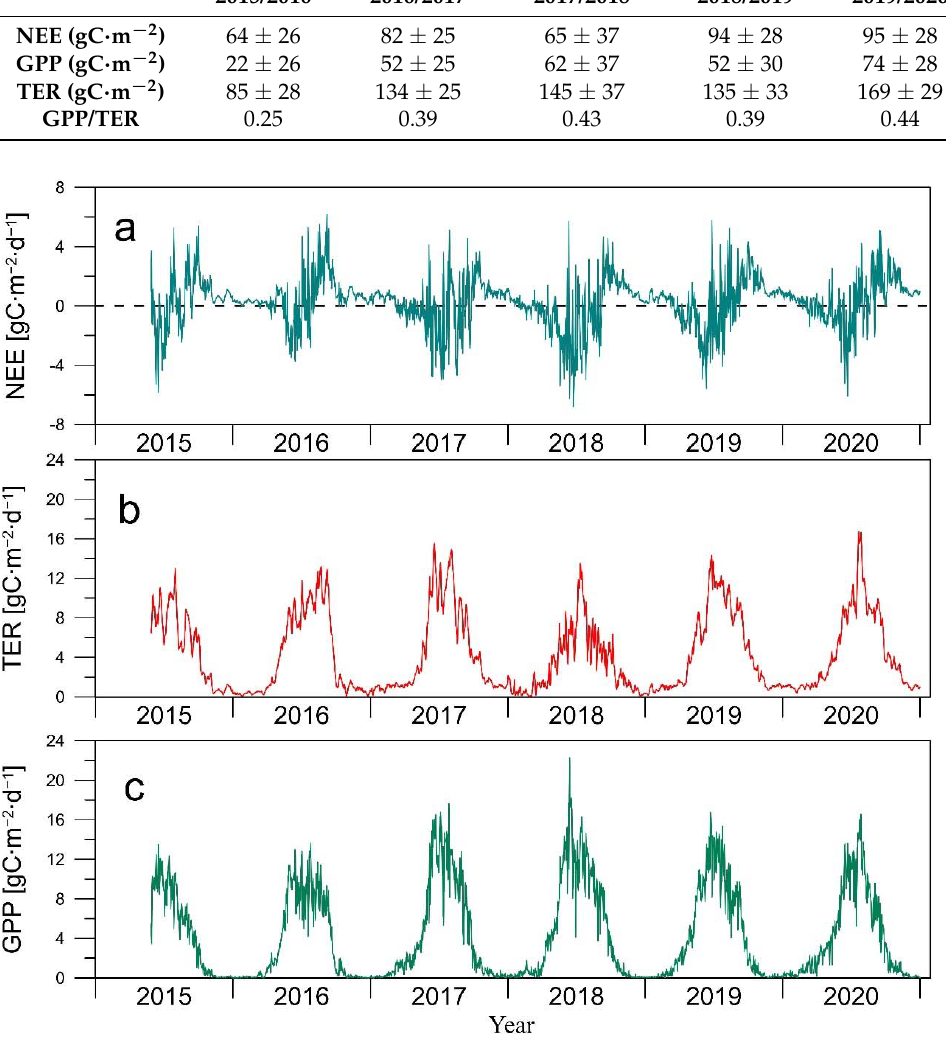
Figure 3. Seasonal courses of the daily sums of CO 2 fluxes in the nemorose spruce forest in the 2015–2020 period: ( a ) net ecosystem exchange (NEE), ( b ) total ecosystem respiration (TER), and ( c ) gross primary production (GPP).